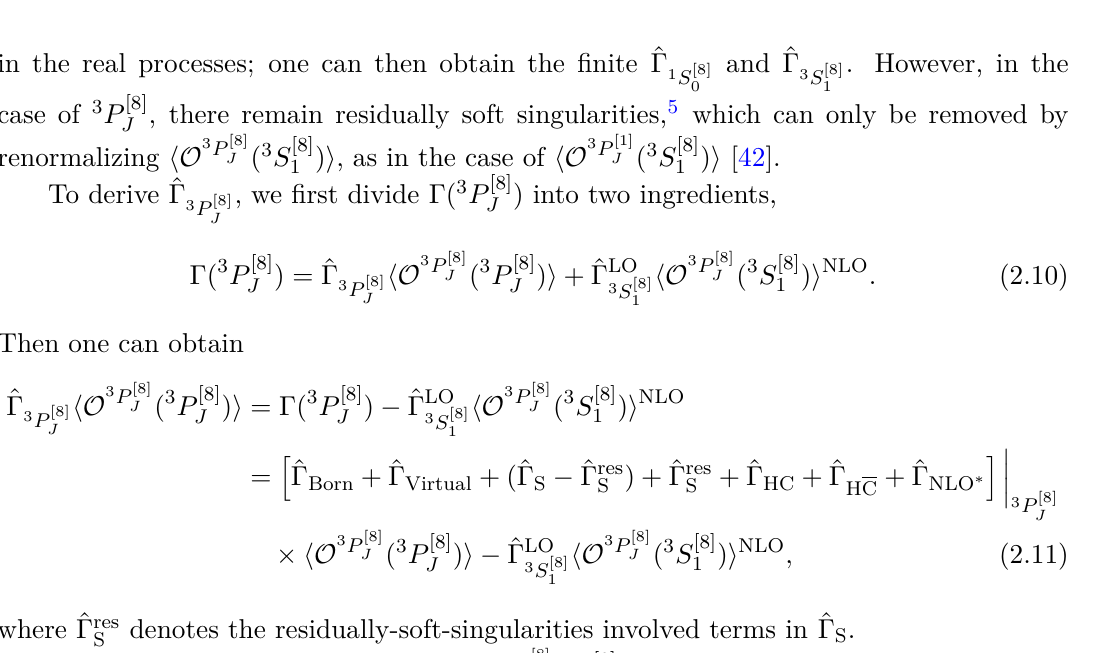
, 3 S [8] , and 3 P [8] 0 1 J